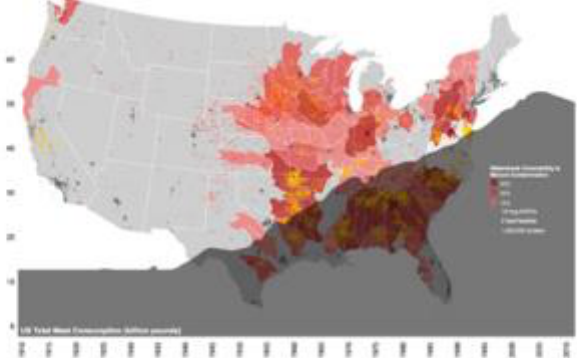
Figure 1. Mapping livestock production, meat consumption and watershed contamination